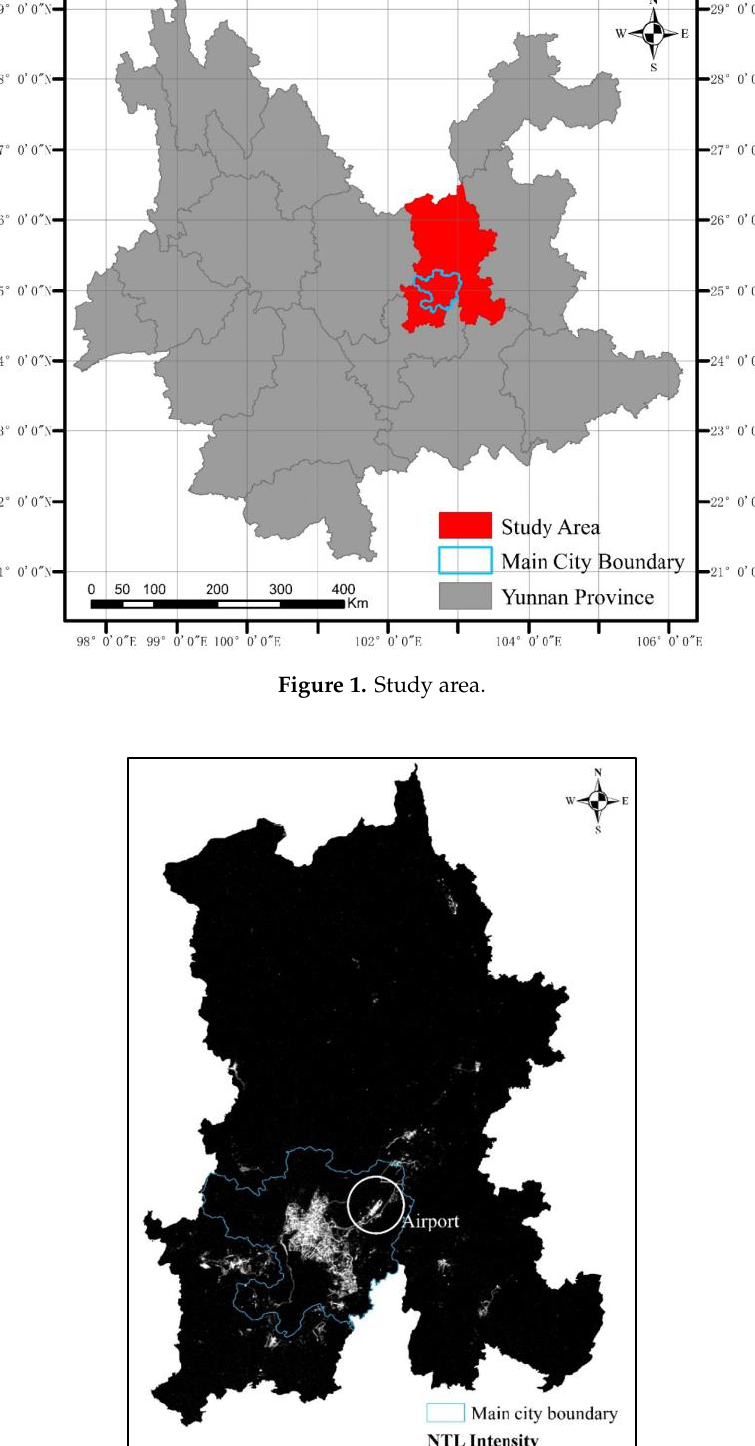
Figure 2. Preprocessing results of NTL data.